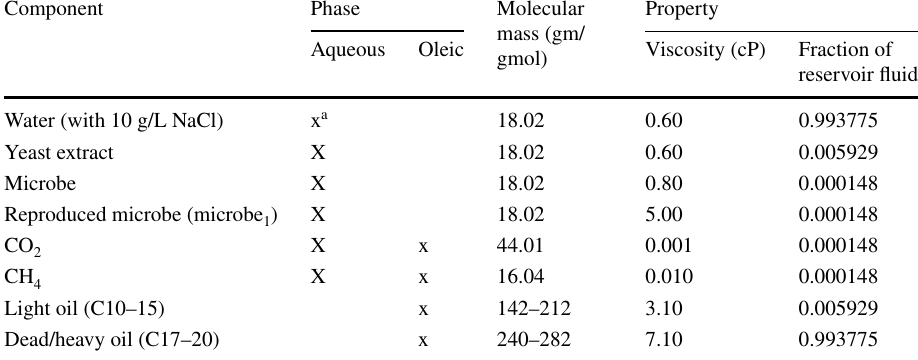
a Symbol ‘x’ represents the presence of a component in a